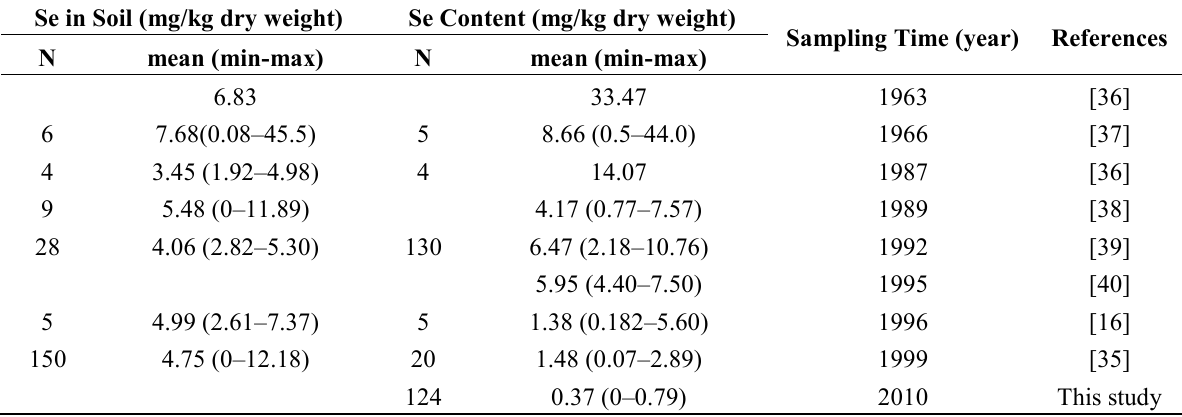
Table 5. The variation of Se in soil and corn in the past 40